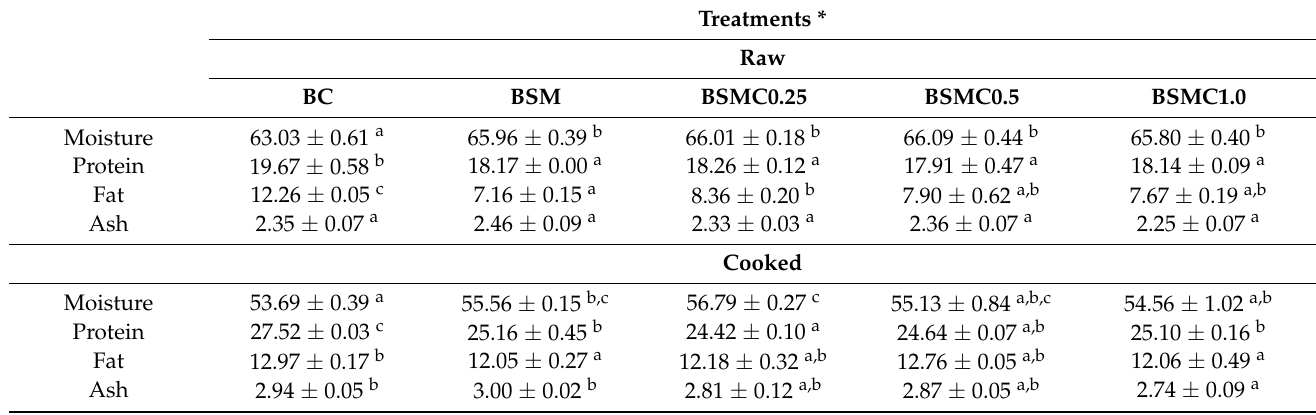
Table 3. Effect of partial substitution of pork backfat by a gelled emulsion of maca flour, soybean oil, and chincho essential oil on the chemical composition (%) of raw and cooked beef burgers. Treatments * Raw BSMC0.25 BSMC0.5